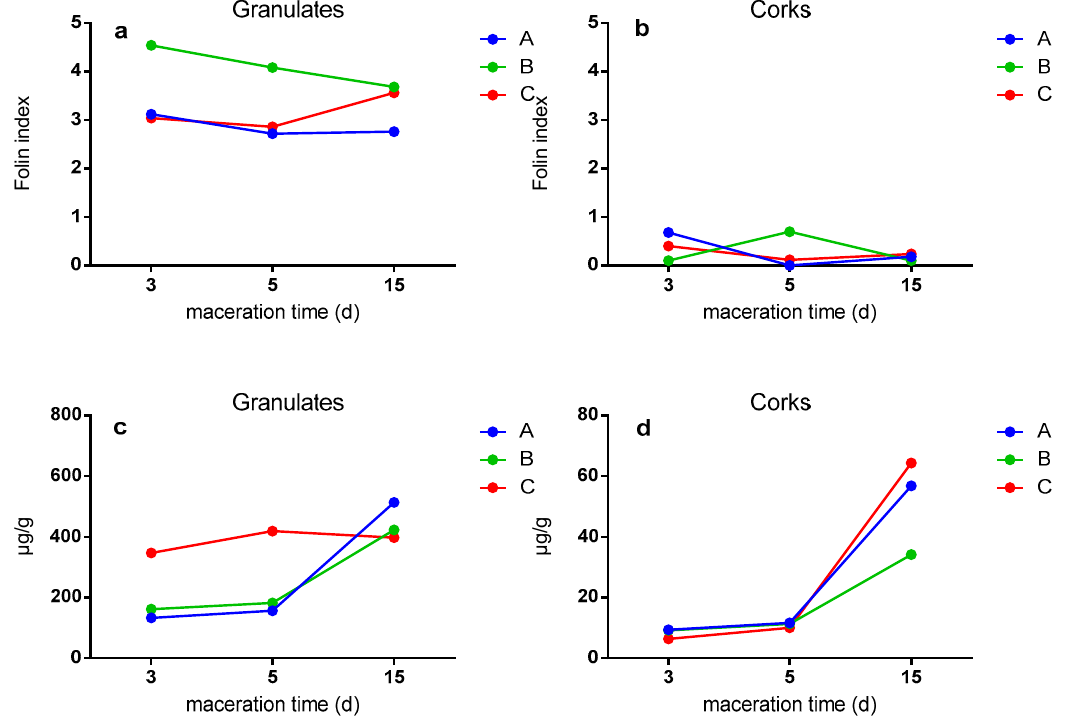
Figure 4. Folin–Ciocalteu index ( a and b ) and phenolic content determined by HPLC ( c and d ; note difference in y -axis scales). Particle size from cork stoppers and their respective granulates, A; high, B; medium, C; small.